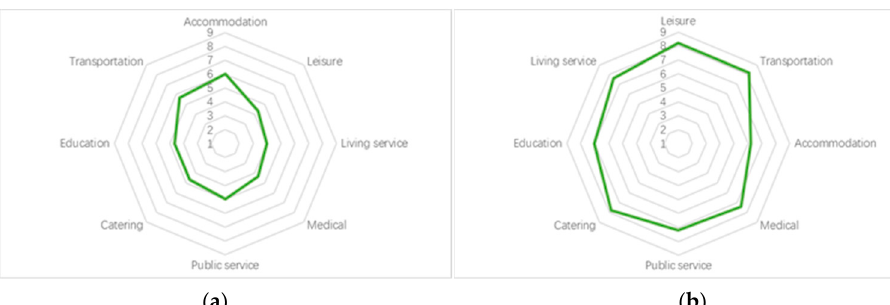
Figure 10. POI cluster level thermal map.